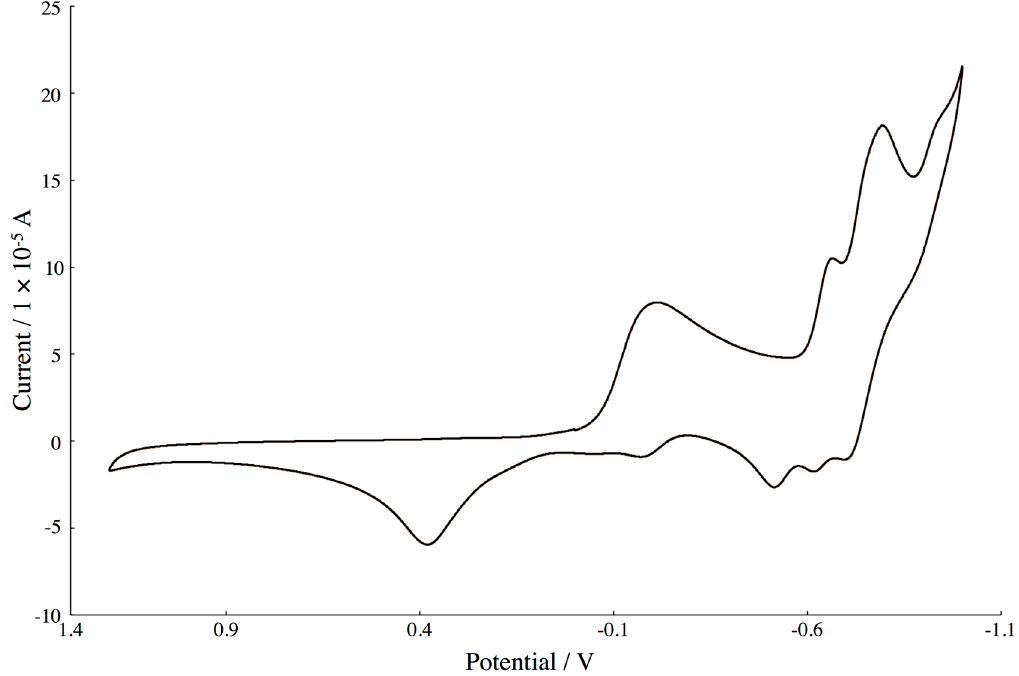
Figure 5. Cyclic voltammograms (CV) of 0.5 mM potassium salt of β , β -Fe 4 -open in 0.5 M potassium acetate buffer, pH 4.8, scan rate 25 mV·s − 1 , under N 2 .